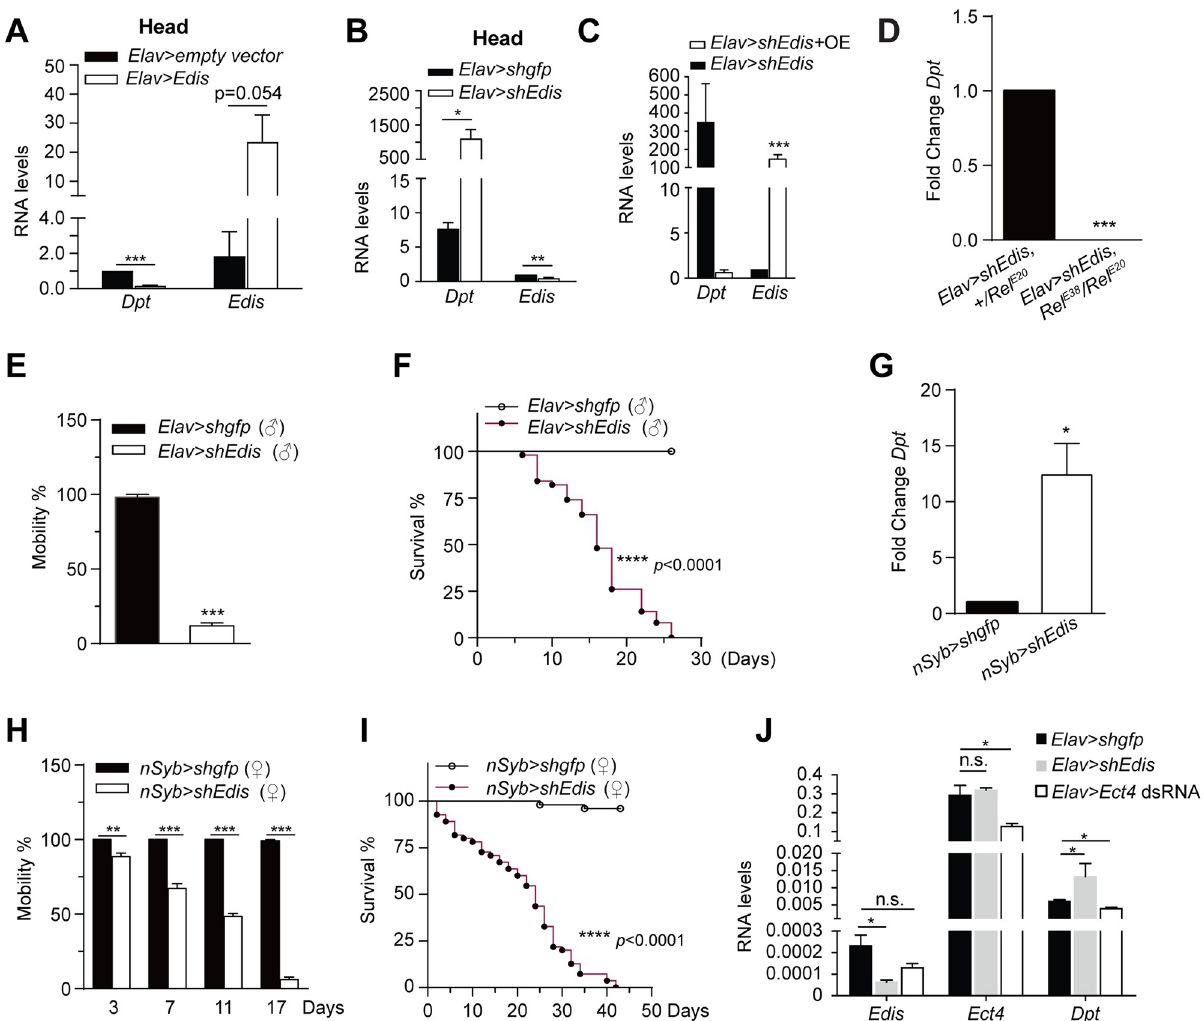
Fig 4. Neuron-specific Edis depletion leads to hyperactivation of innate immunity, impaired locomotion and shortened lifespan. ( A ) The UAS-Edis or control UAS-empty vector transgenic flies were crossed to the Elav-Gal4 driver line. Total RNA was prepared from dissected fly heads, and levels of the circular Edis RNA or Dpt mRNA were measured (student t test, n = 3, � p < 0.05; ��� p < 0.001). ( B ) The UAS-shEdis or control UAS-shGFP flies were crossed to the neuron-specific Elav-Gal4 driver line. Levels of the Ect4 , Edis or Dpt in fly head samples were measured (student t test, n = 3, � p < 0.05; ��� p < 0.001). ( C ) The UAS-Edis or control UAS-laccase 2 empty vector transgenes were introduced into the Elav > shEdis flies. Total RNA was prepared from dissected fly heads, and levels of the circular Edis RNA or Dpt mRNA were measured (student t test, n = 3, ��� p < 0.001). ( D ) The UAS- shEdis flies were crossed to the Elav-Gal4 driver line. Female progeny either in the Relish heterozygous ( Rel E20 /+) or trans-heterozygous ( Rel E20 / Rel E38 ) background were collected at ~3 weeks of age, and levels of Dpt in fly heads were measured (student t test, n = 3, ��� p < 0.001). ( E ) Locomotor activity of 2-5d old Male Elav > shEdis and control flies were measured and shown (student t test, n � 4, ��� p < 0.001). ( F ) Survival of male Elav > shEdis and control flies were measured and shown (log rank test, n = 4 to 8, ���� p < 0.0001). ( G-I ) The UAS-shEdis or control UAS-shGFP flies were crossed to a second neuron-specific nSyb-Gal4 driver line. Level of Dpt RNA in fly heads ( G , student t test, n = 3, � p < 0.05), climbing activity ( H , student t test, n � 3, ��� p < 0.001) and lifespan ( I , log rank test, n = 4 to 11, ���� p < 0.0001) of female progeny are shown. ( J ) The UAS-dsEct4 , UAS-shEdis or control UAS- shGFP flies were crossed to the neuron-specific Elav-Gal4 UAS-Dcr-2 driver line. Levels of Ect4 , Edis and Dpt transcripts were measured (student t test, n = 3, n = 2 for Elav > shEdis samples for measuring Dpt levels, � p < 0.05; ns,